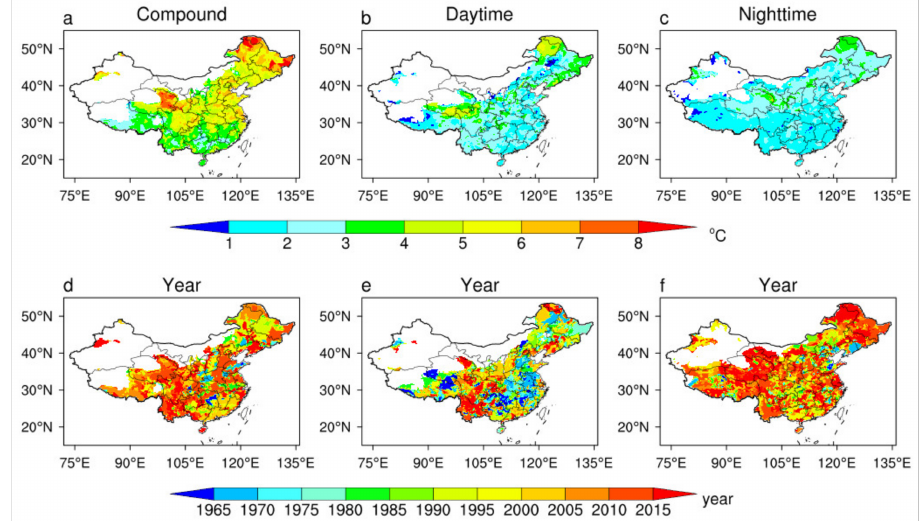
Figure 7. The maximum intensity of the wet ( a ) compound, ( b ) daytime and ( c ) nighttime HWs during 1961–2020, and ( d – f ) the year corresponding to the maximum